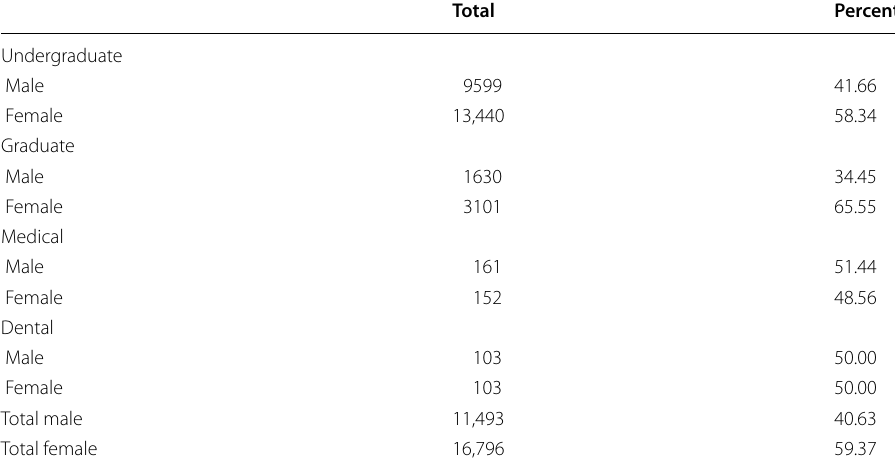
Table 2 Fall 2015 ECU gender data broken down by program (https:// ipar. ecu. edu/ wp- conte nt/ pv- uploa ds/ sites/ 130/ 2020/ 01/ Fact- Book- 15- 16.